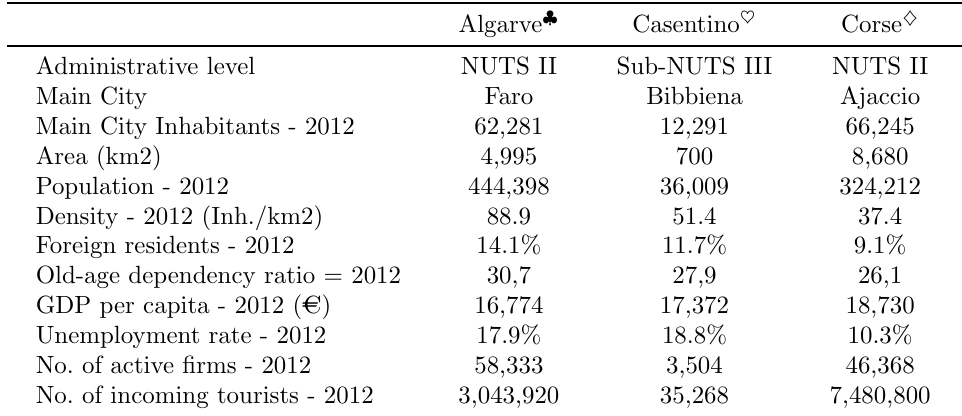
Table 4: Synthetic data on Algarve, Casentino and Corse Algarve